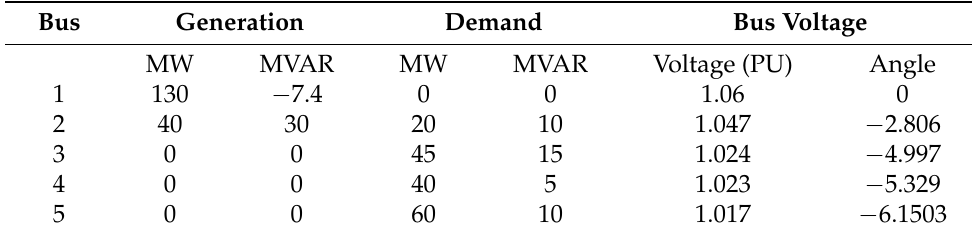
Table 2. Power flow results of the 5-Bus system.